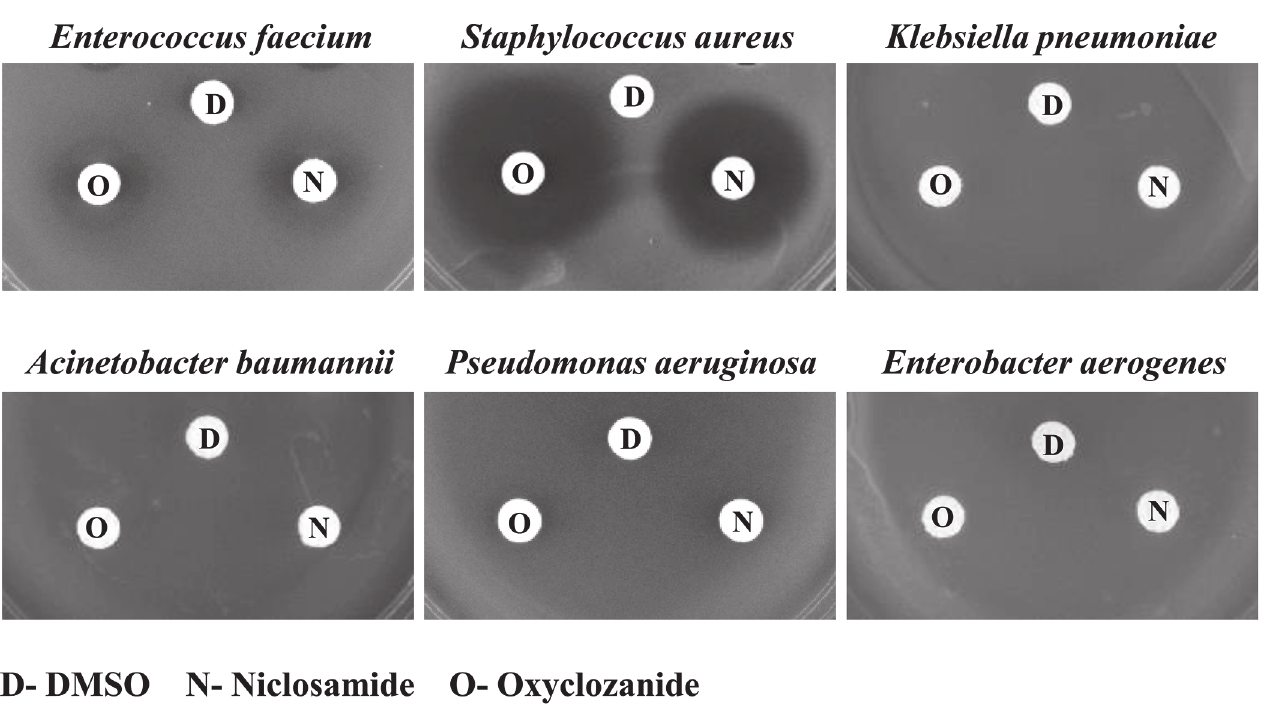
Fig 3. Antimicrobial activity of niclosamide and oxyclozanide against the ESKAPE pathogens. Disc diffusion assay to detect zone of growth inhibition due to bactericidal activity of niclosamide and oxyclozanide against E . faecium , S . aureus methicillin resistant strain (MW2), K . pneumoniae , A . baumannii , P . aeruginosa and E . aerogenes .